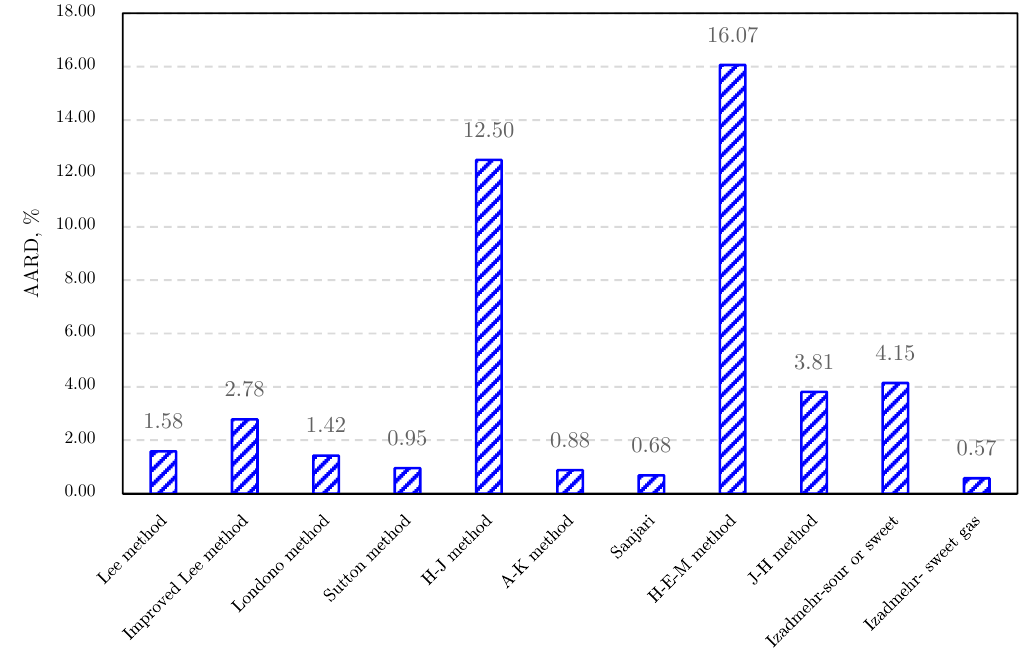
Figure 31. The AARD of different models for gas viscosity calculation at 293.15 K.